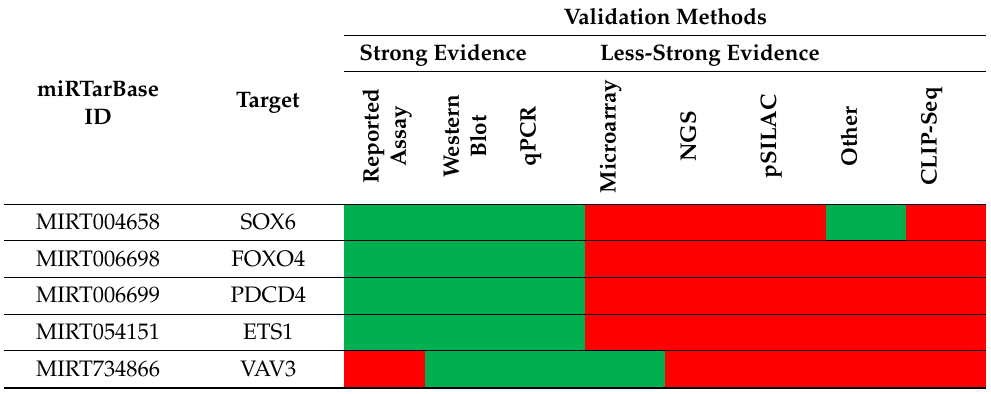
Table 5. Summary of the miRNA interactions referred to hsa-miR-499a-5p, supported with at least 3 positive tools; green = validated methods, red = unvalidated methods. The methods have been distinguished as strong or less-strong